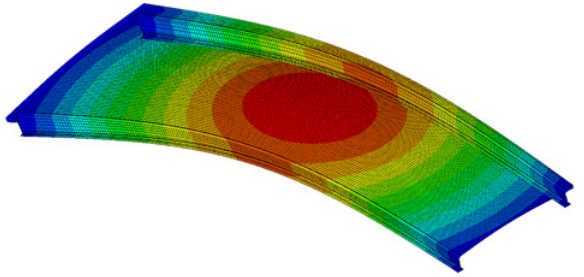
A possible excessive dynamic excitation of a composite